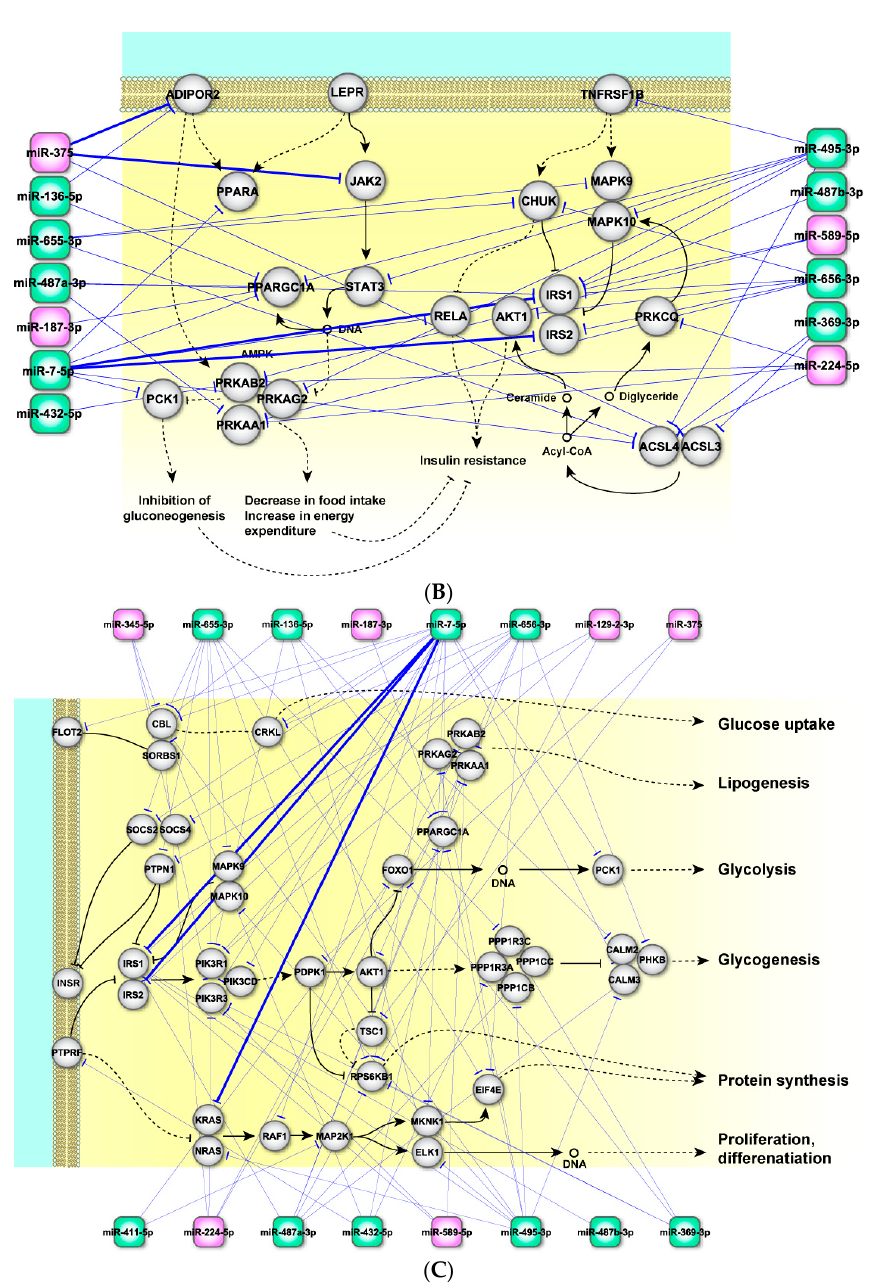
Figure 2. Schematic diagram of the microRNA-mRNA interaction networks in pancreatic islets. The networks are built based on the KEGG pathway map: T2DM pathway (KEGG hsa04930) ( A ); adipocytokine pathway (KEGG hsa04920) ( B ); and insulin signaling pathway (KEGG hsa04910) ( C ). The genes are indicated by circles and miRNAs by squares. For detailed descriptions of node shape, edge size, edge color and arrow shapes see inserted legend under ( A ). The predicted miRNA-mRNA interactions are indicated by light blue lines, and the thick blue lines indicate validated miRNA-mRNA interactions. Interactions denoted in KEGG pathways were presented as black solid or dotted lines indicating direct or indirect interactions, respectively. The identity of genes and miRNAs involved in the process are listed, and the colors indicate the expression level changes in T2DM islets compared to the control; red indicates a higher level in patients; and green represents lower levels compared to the control.